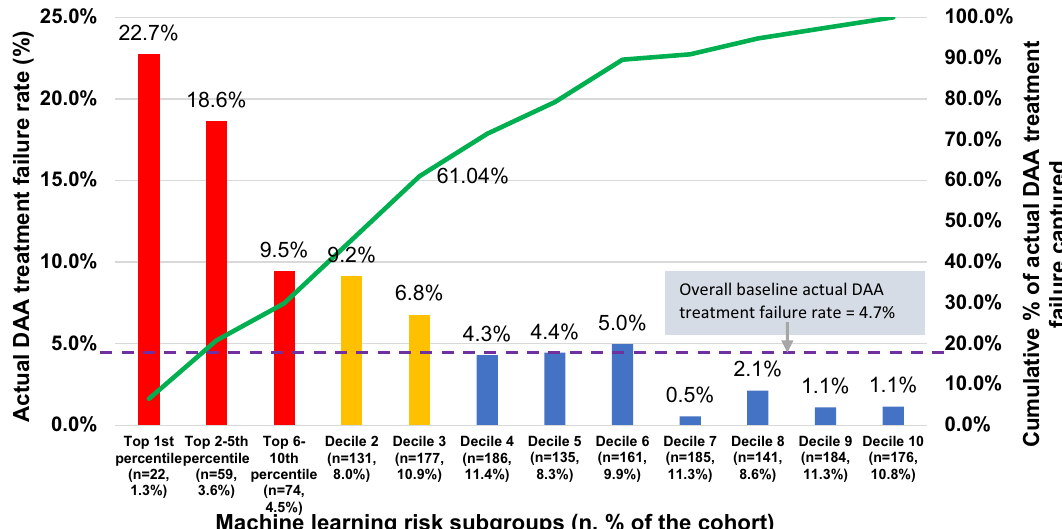
Figure 2. Electric net model assessment of direct-acting antiviral (DAA) treatment failure rates for each decile risk subgroup. Data were derived using the validation